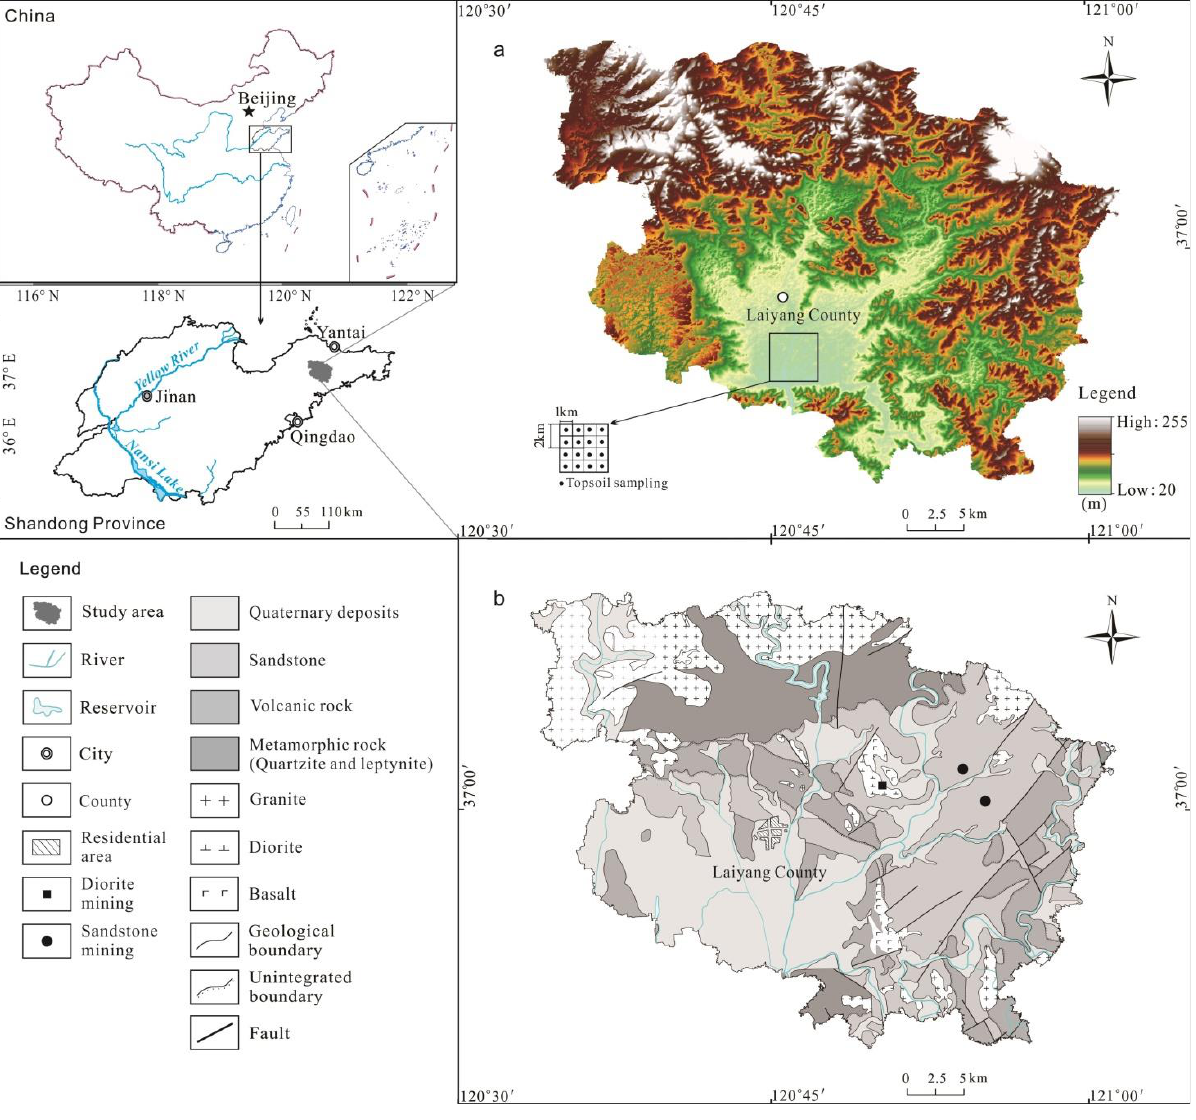
Figure 1. ( a ) Location and ( b ) geological map of the study